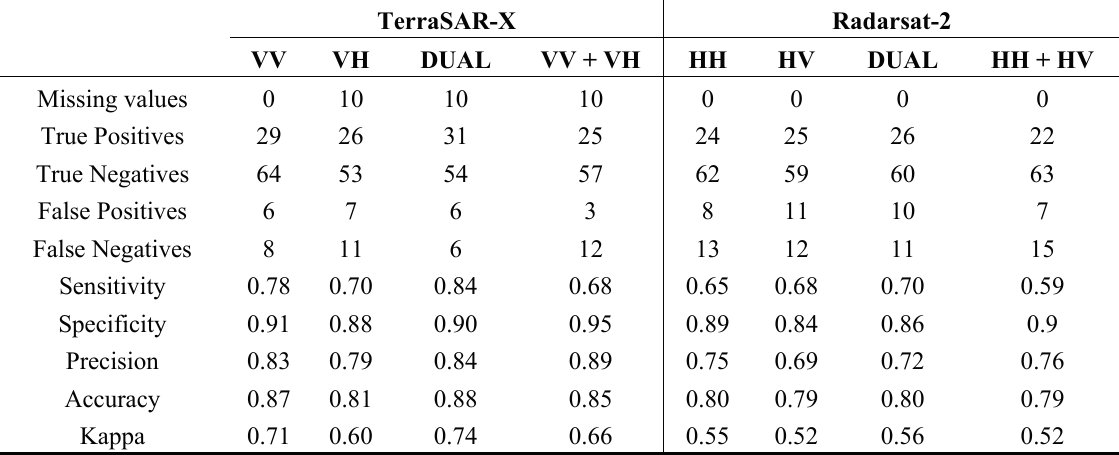
Figure 9. Plot showing the classification method based on the training set. ( a ) TerraSAR-X data and ( b ) Radarsat-2 data. The red points represent the class with <5% shellfish and the blue points the class with >5% shellfish. The marginal plots show the logistic regression that was used to find the threshold values (dotted lines) at the intersection, where the probability is 50% for single-polarized classifications. The solid line is the threshold value for the multivariate logistic regression for dual-polarized data. See Table 3 for the statistics. Table 3. Training statistics for the shellfish classifiers used. Thresholds (in dB) and statistics were calculated using logistic regression for co-polarized data (VV or HH), cross-polarized data (VH or HV), dual-polarized (DUAL) data and a combination of both single-band thresholds (VV + VH or HH +